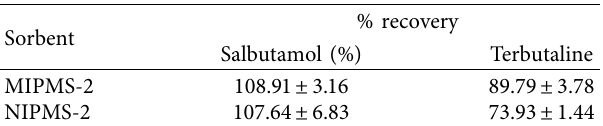
Figure 4: (a) Adsorption capability of MIPMS-1 and NIPMS-1. (b) Adsorption capability of MIPMS-2 and NIPMS-2. Note: ACN � acetonitrile. Table 3: Results of adsorption capacity evaluation using Freundlich isotherm and Langmuir isotherms.